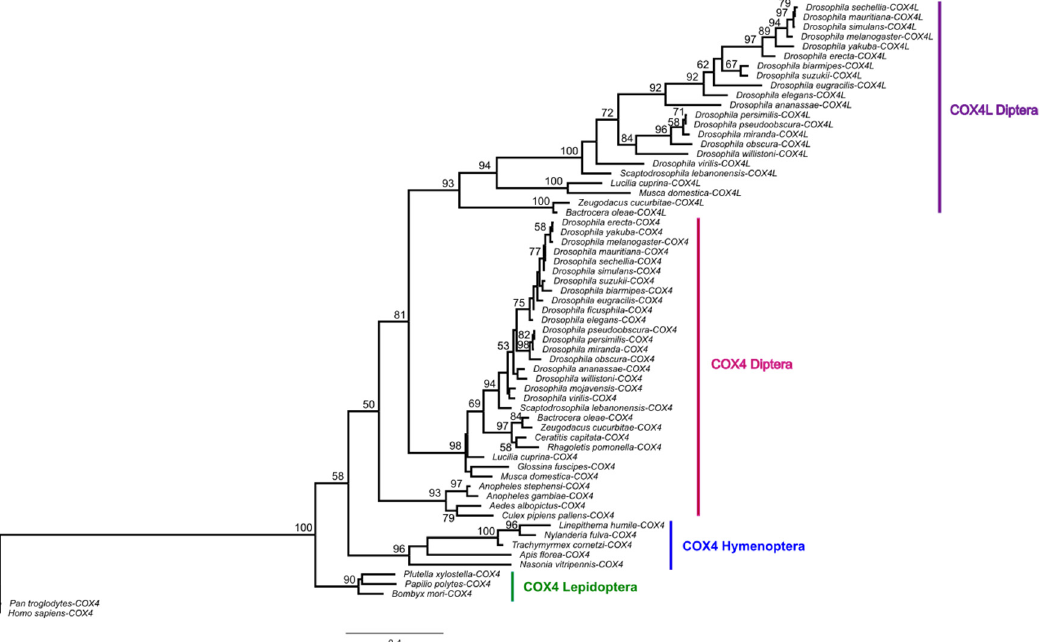
Figure 1. Maximum likelihood tree of COX4 and COX4L , using amino acid sequences. Multiple alignments of protein sequences were performed using ClustalW [57] implemented in Geneious (Version 2020.1) [58]. The maximum likelihood phylogenetic tree was constructed using the BlOSUM62 substitution model with 100 bootstrap branch support in PhyML [52], applied in Geneious. Only bootstrap support values ≥ 50 are shown. We used FigTree (Version 1.4.4) (http://tree.bio.ed.ac.uk/software/figtree, accessed on 30 April 2021) to visualize all phylogenies.